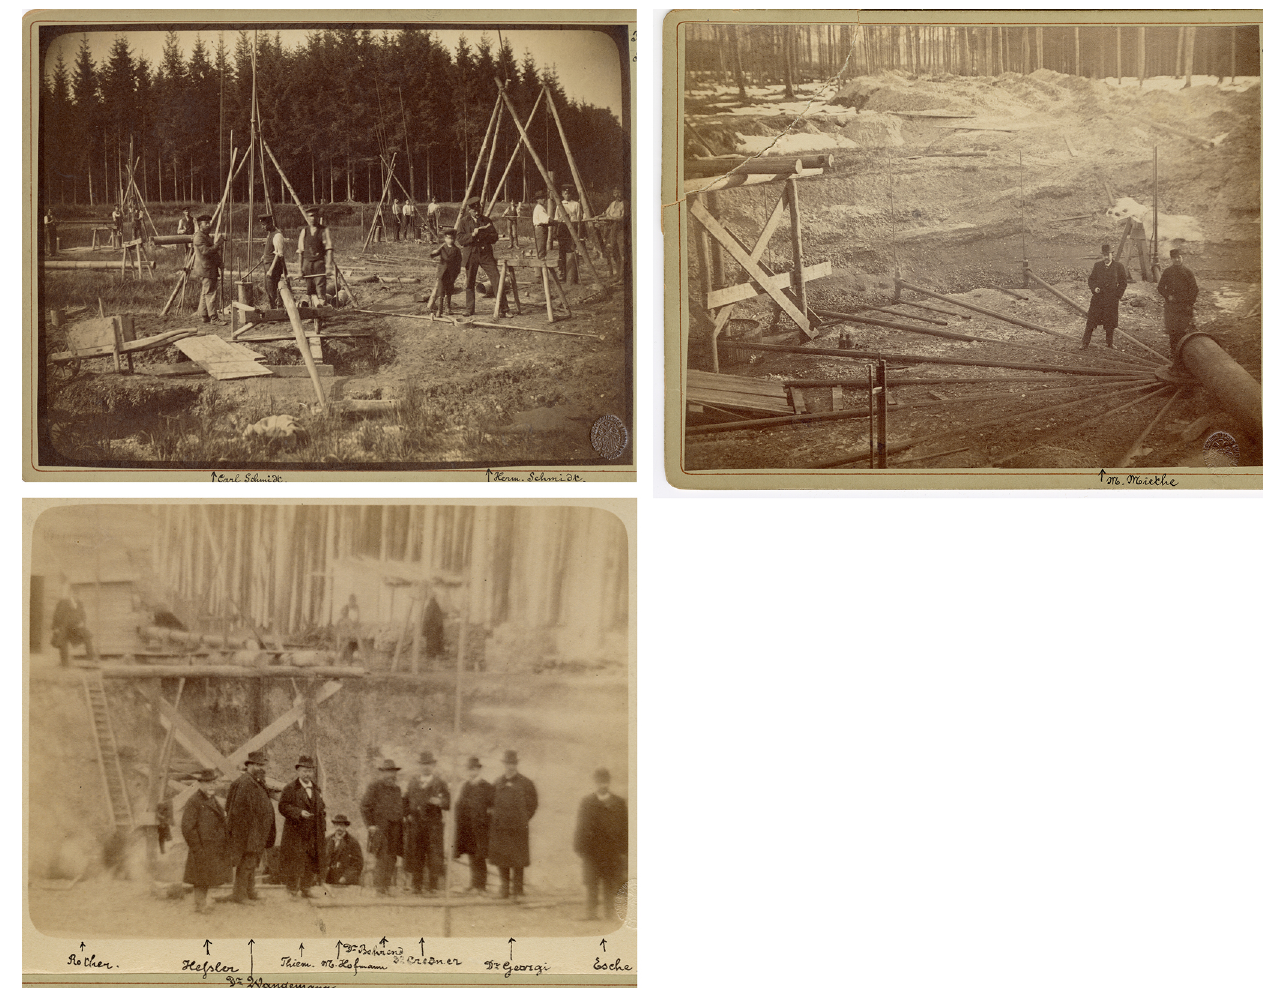
Figure 4. Construction of a Ringbrunnen at Leipzig–Naunhof, around 1887. The upper left panel shows the drilling of vertical wells. The upper right panel provides a view of the radial pipelines connecting the vertical wells (visible at the end) to the central collector shaft. In the lower left panel, Adolf Thiem is visiting the construction site (third from left, lower row). Also present is Hermann Credner, head of the Saxon Geological Survey, and Max Rother (left panel), one of Thiem’s pupils (photos: Stadtarchiv Leipzig).